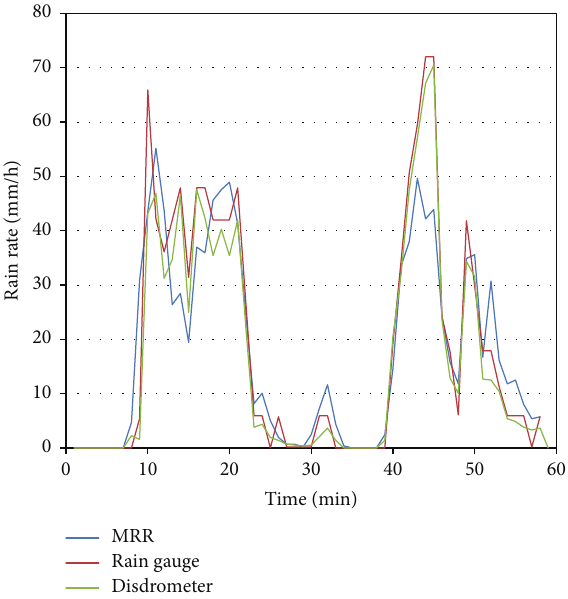
Figure 12: Comparison of the different precipitation intensities measured with the three